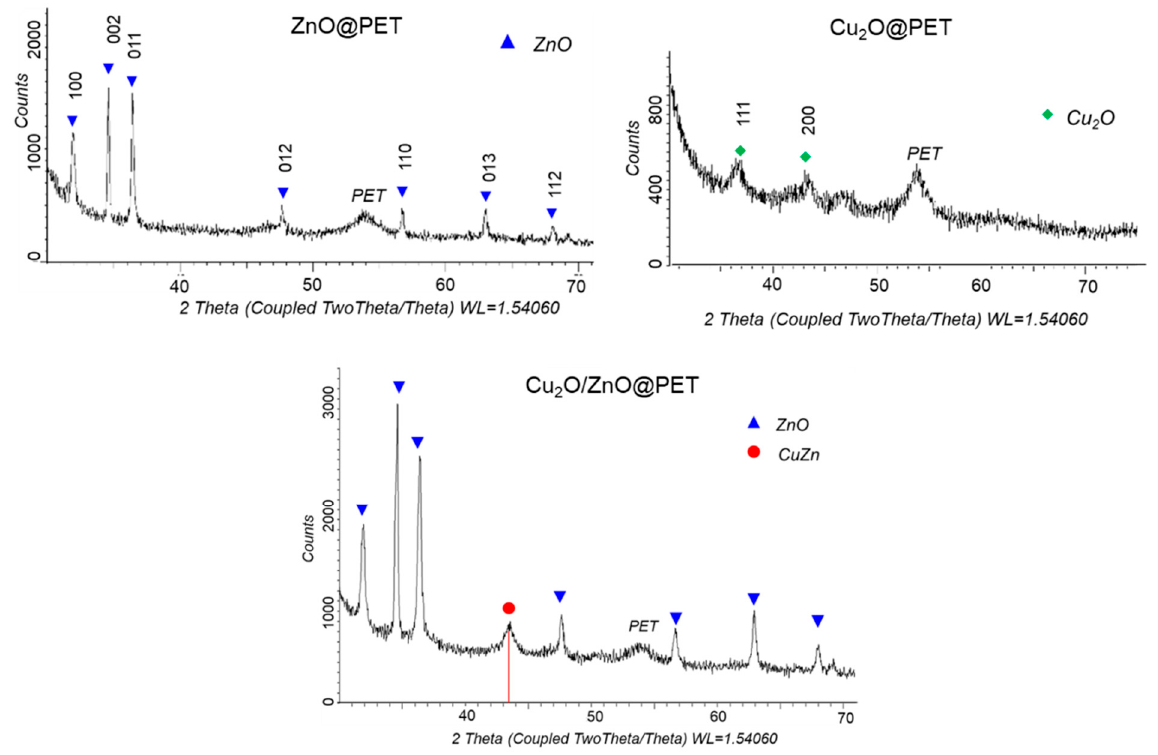
Figure 3. X-ray diffraction patterns of ZnO@PET, Cu 2 O@PET and Cu 2 O/ZnO@PET composites. Table 2. Changes in the crystal structures of the composites according to XRD